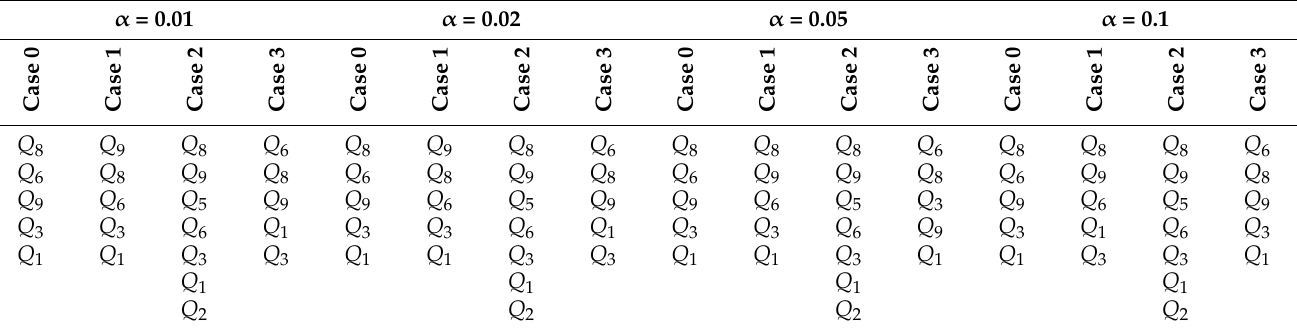
Table 26. Ranking Lists of Dominate Nodal Reactive Powers when a Ranking Criterion is the Index κ for Different Study Cases and Different Values of Level α